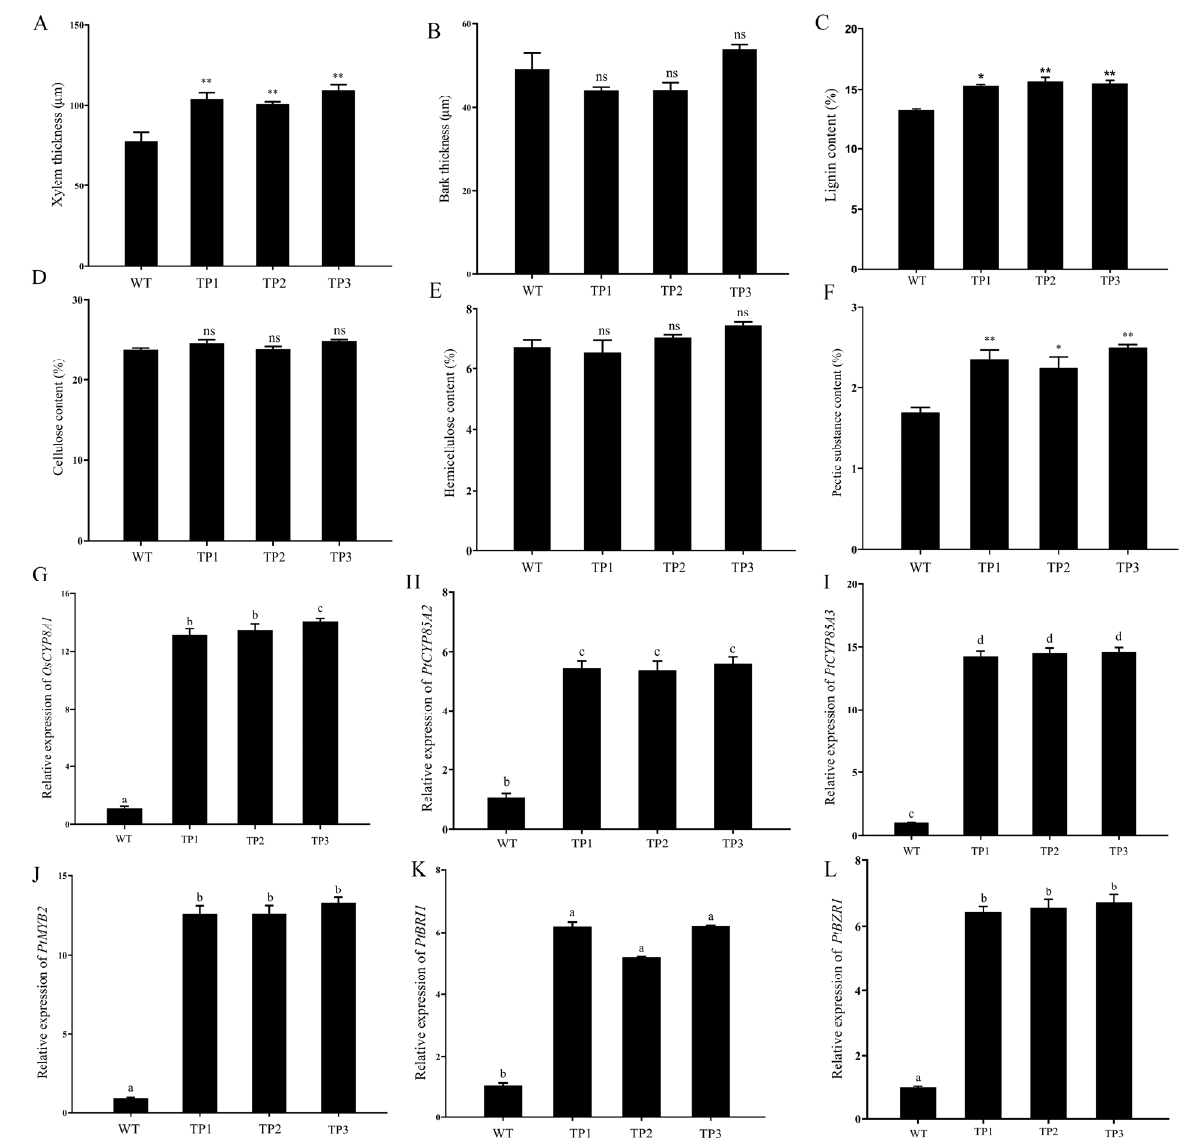
Figure 8. Effects of OsCYP85A1 on xylem differentiation in transgenic poplar. ( A , B ) Measurement of xylem and bark. ( C , D ) Cellulose and lignin contents in the xylem tissues. ( E , F ) Hemicellulose content and pectic content. ( G – L ) Expression analysis of secondary cell wall synthesis-related MYB transcription factors and CS synthesis-related genes. The expression level of these genes in the stem of WT was set to 1. ns, nonsignificant; error bars represent the SDs from three biological replicates. * and ** indicate significant differences in comparison to WT at p < 0.05 and p < 0.01, respectively (Student’s t -test). Error bars represent mean ± SD of three biological replicates. Di ff erent le tt ers indicate a signi fi cant di ff erence using the Tukey–Kramer test: p < 0.05.